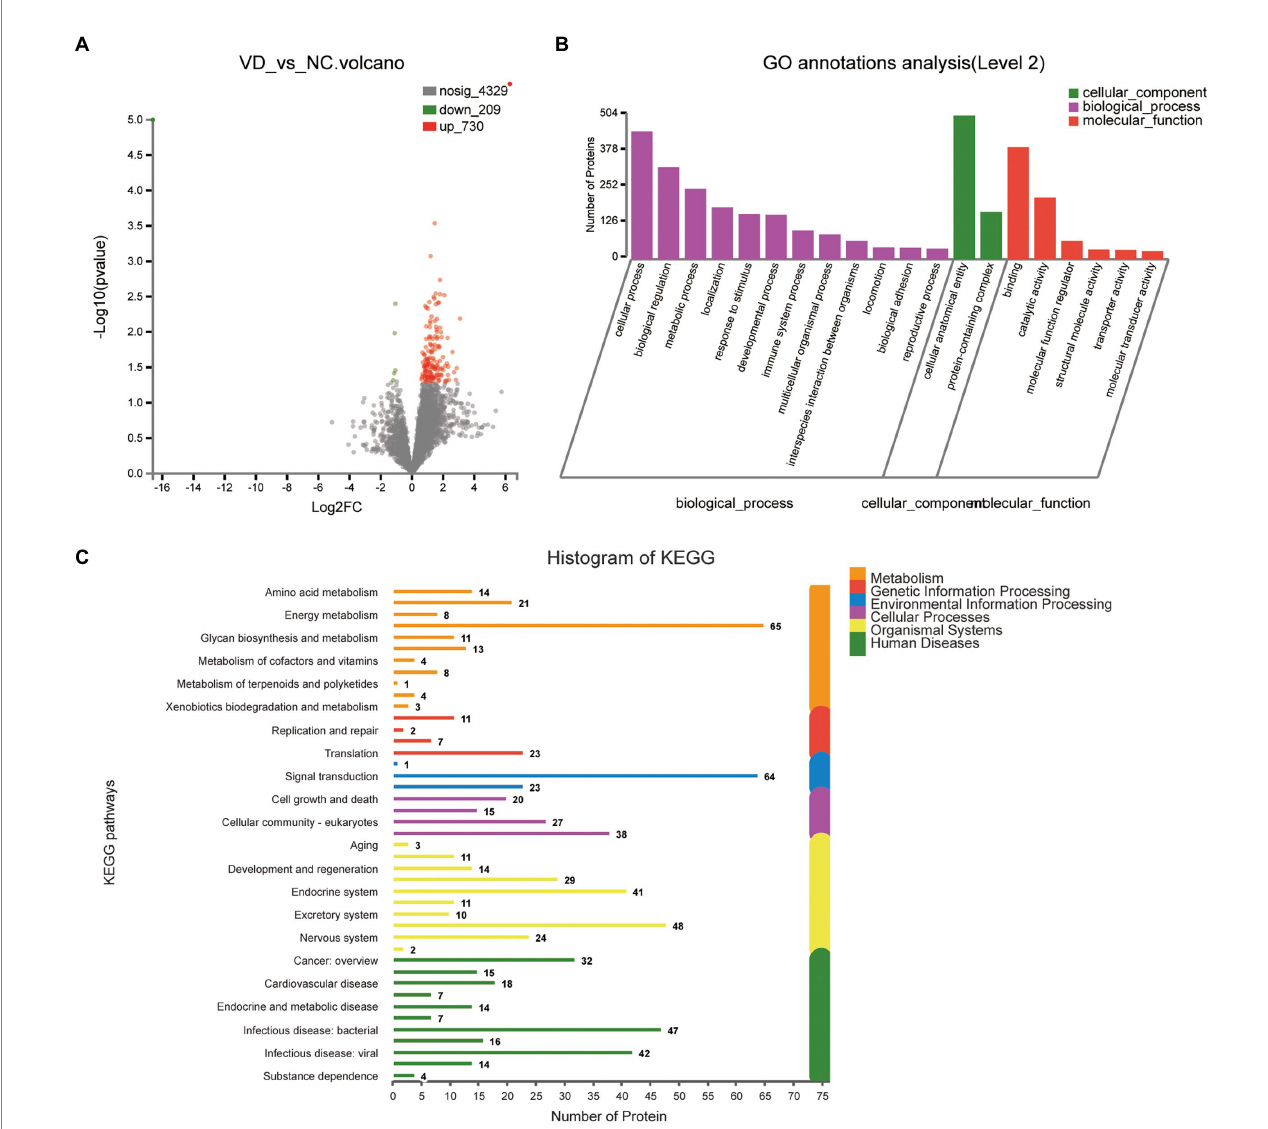
FIGURE 3 Volcano plots of quantified proteins and functional analysis of the differentially expressed proteins in the urine between VD and NC subjects (Notes same as figure 3-1). (A) Volcano plot of mean TMT log 2 ratio plotted against the minus log 10 (value of p ) of the one-sample T -test for the respective quantified proteins. Each point in the figure represents a specific protein. The point on the left is the protein with down-regulated expression, and the point on the right is the protein with up-regulated expression. Green points represent down-regulated differential proteins and red points represent up-regulated differential proteins. (B) GO enrichment analysis of differential urine-excretory proteins. Purple bars denote the enriched biological processes, green bars are enriched cellular components, and red bars are enriched molecular functions. Protein numbers enriched in each category are presented with the bars. (C) The differentially expressed proteins are associated with diseases and signal transduction pathways. The number of proteins associated with each category is listed. The different color pathways represent the different categories to which they belong. According to the KEGG metabolic pathways involved in proteins, they can be divided into 7 categories: Metabolism (M), Genetic Information Processing (GIP), Environmental Information Processing (EIP), Cellular Processes (CP), Organismal Systems (OS), Human Diseases (HD), Drug Development